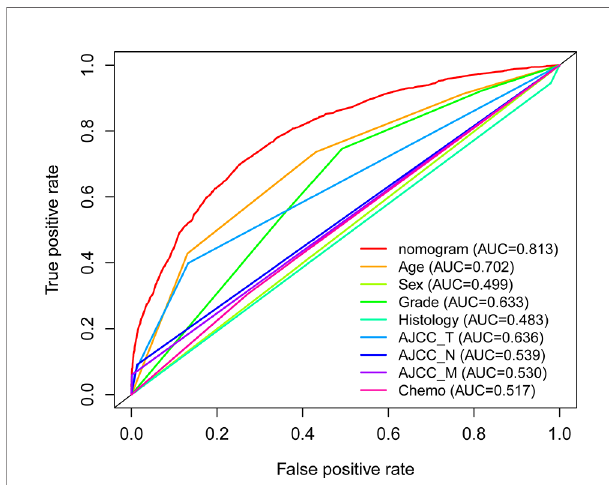
FIGURE 6 | ROC analysis for multiple indicators using the full analysis